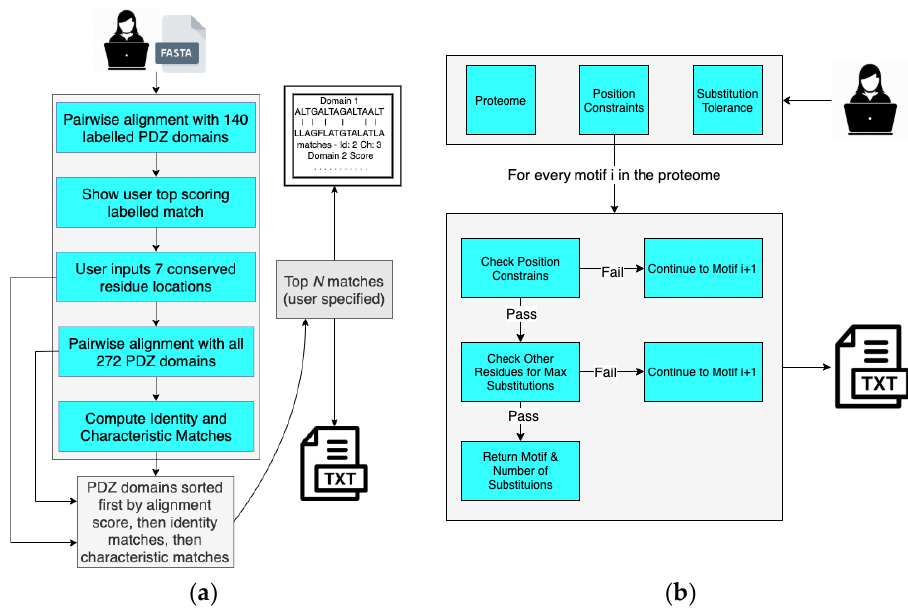
Figure 4. The Domain Analysis and Motif Matcher (DAMM) software suite. Details of the computational workflow of the Domain Analysis program are in ( a ) and Motif Matcher program are in ( b ).